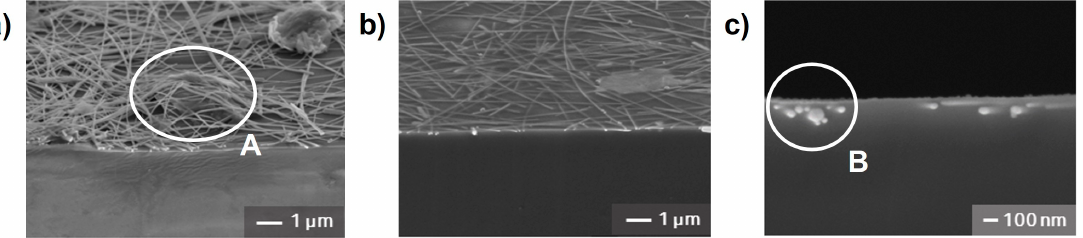
Figure 4. SEM images. ( a ) GCA/AgNW/PET electrode, ( b ) GCA/AgNW/GCA/cPAI-embedded electrode, ( c ) cross section of GCA/AgNW/GCA/cPAI-embedded electrode. (A; GCA, B; cross section of AgNW).